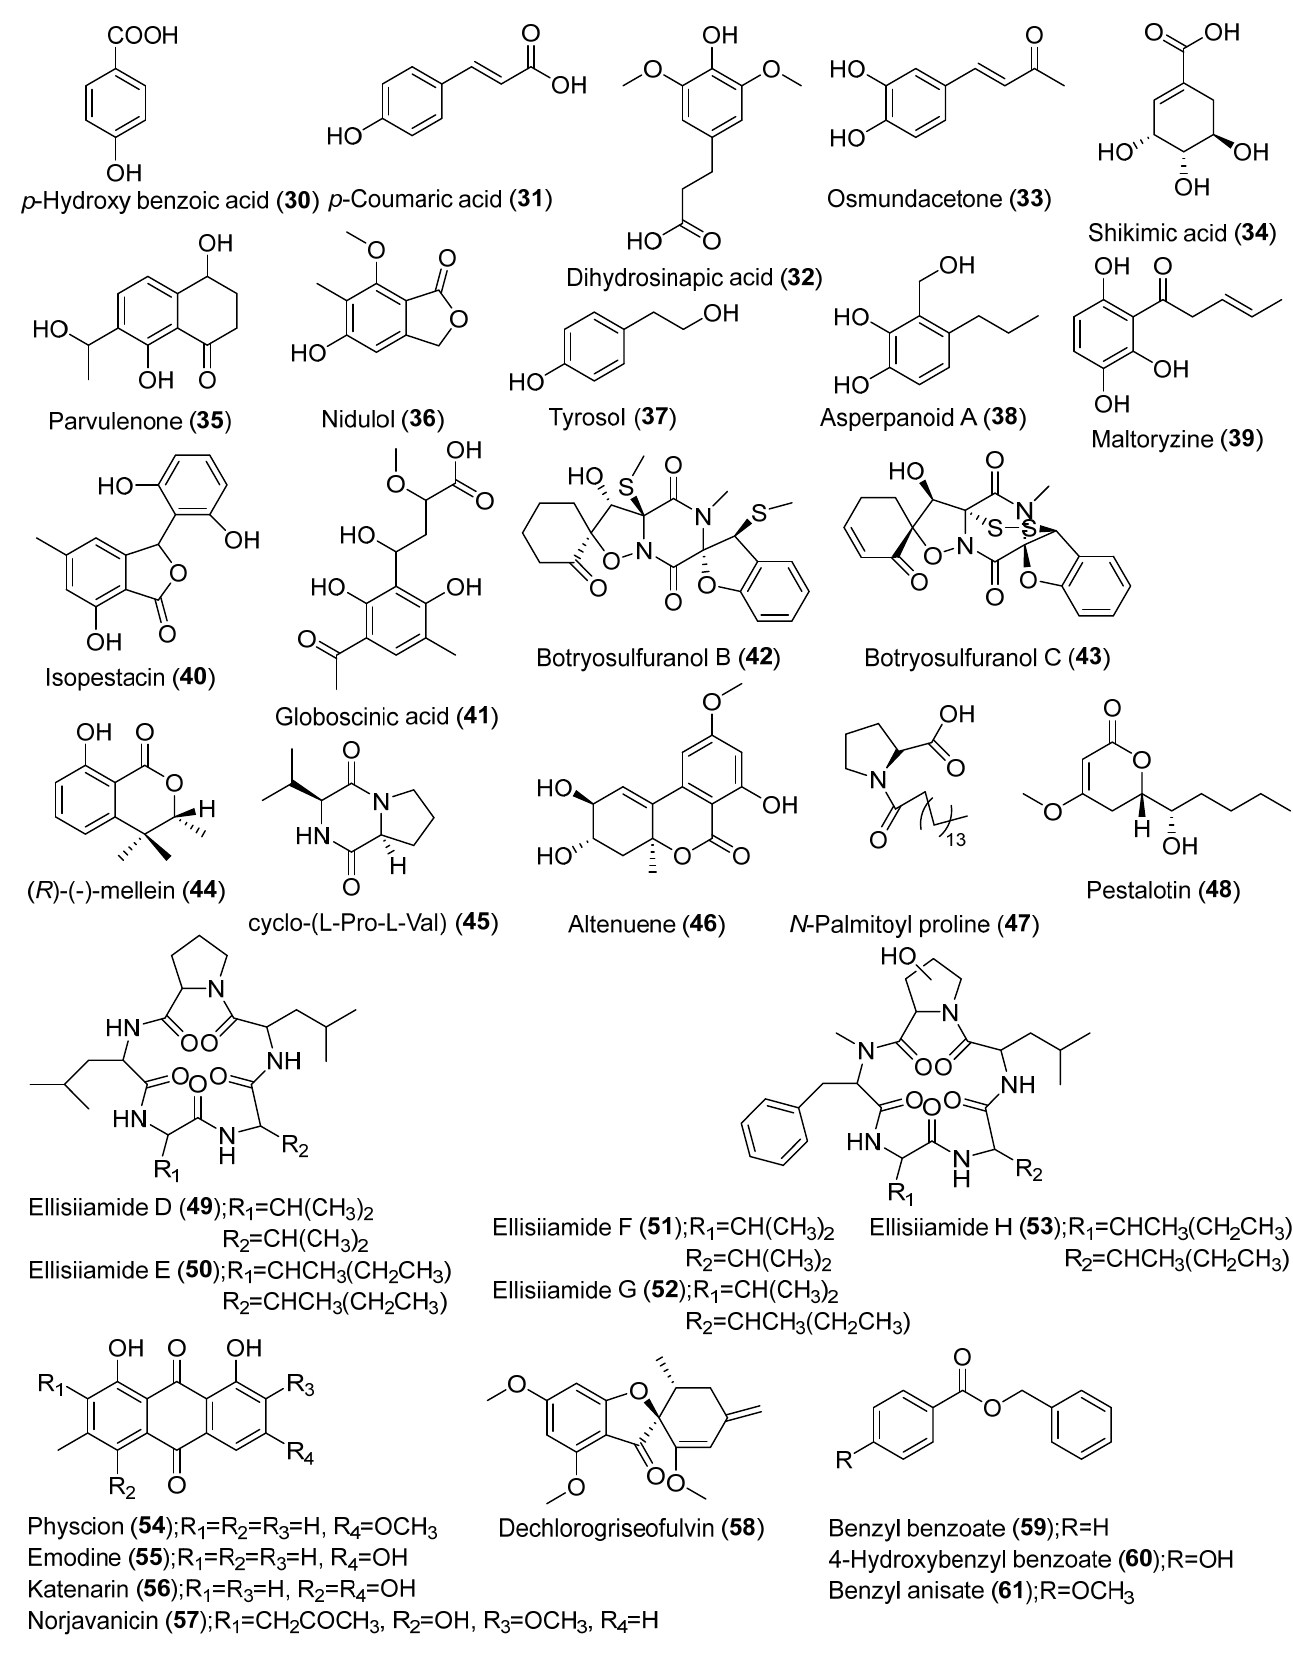
Figure 2. Chemical structures of metabolites ( 1 )–( 61 ).